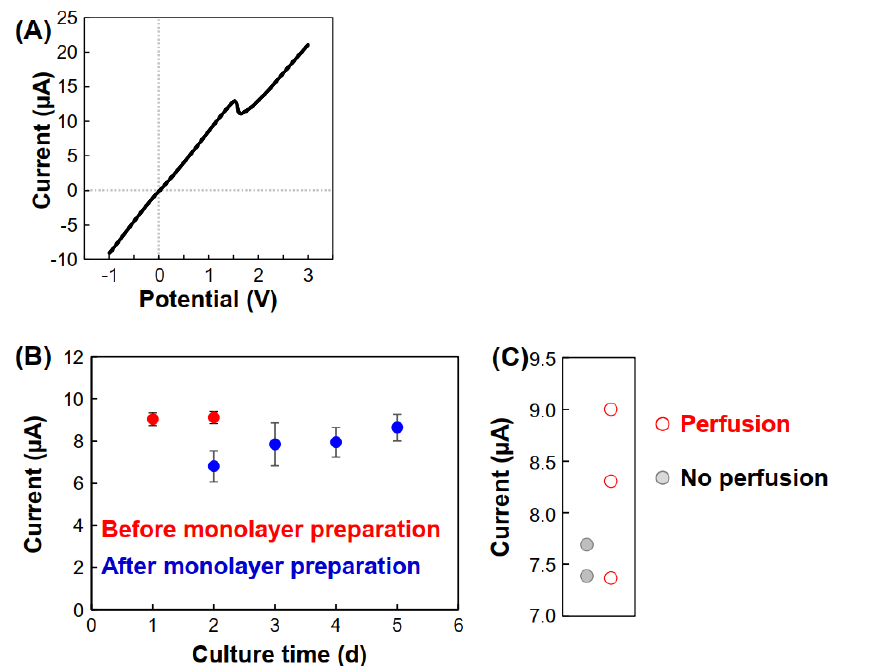
Figure 5. Ion currents at 1.0 V using PBS in Chs. 2 and 4 during the assay. ( A ) Current vs. potential after 1 d. ( B ) Ion current vs. culture time. The values were obtained from the currents 1.0 V of the I-V curves. N = 5. The error bars indicate SDs. ( C ) Ion currents and perfusability after 4 d. The current values of two out of the three perfusion samples were higher than those of the samples with no perfusion.